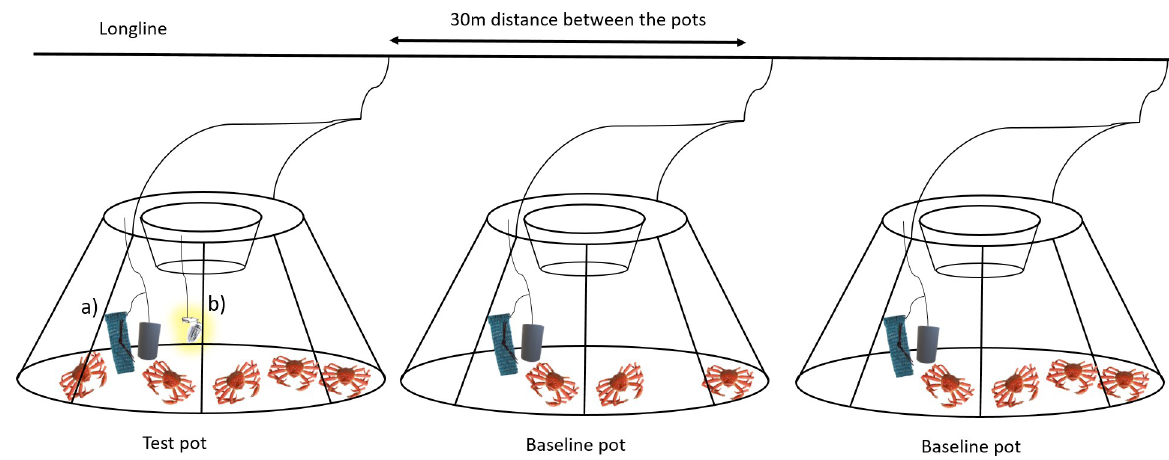
Fig 1. Distances between standard conical pots with top entrance, location of the bait (a) and artificial LED light used for the test pots (b).